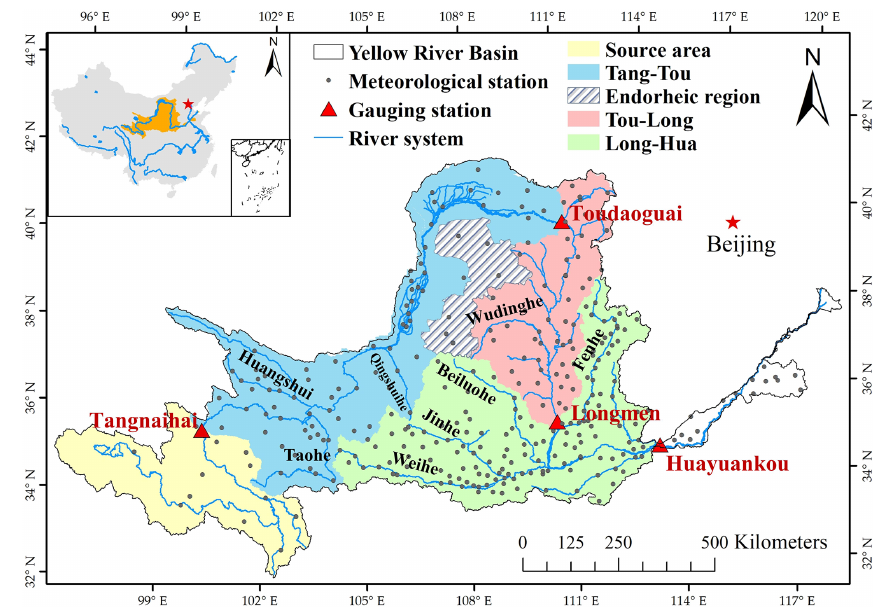
Figure 1. Spatial distribution of the meteorological and streamflow gauge stations in the Yellow River basin (YRB). The insert map shows the location of the YRB in